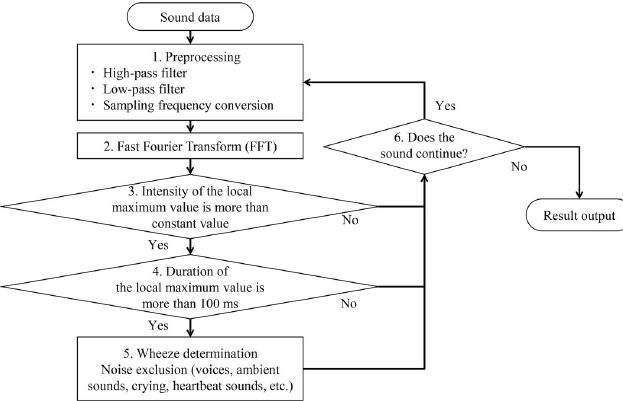
Fig 2. Flowchart of the newly developed wheeze recognition algorithm for